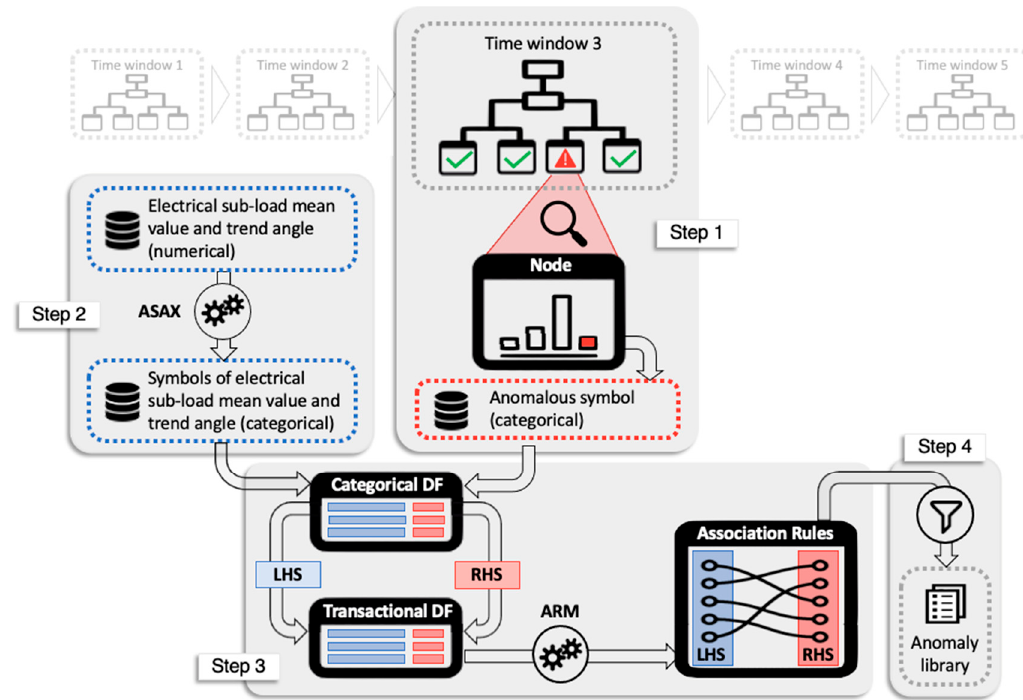
Figure 6. Sub ‐ meter level diagnosis methodology description. Figure 6. Sub-meter level diagnosis methodology